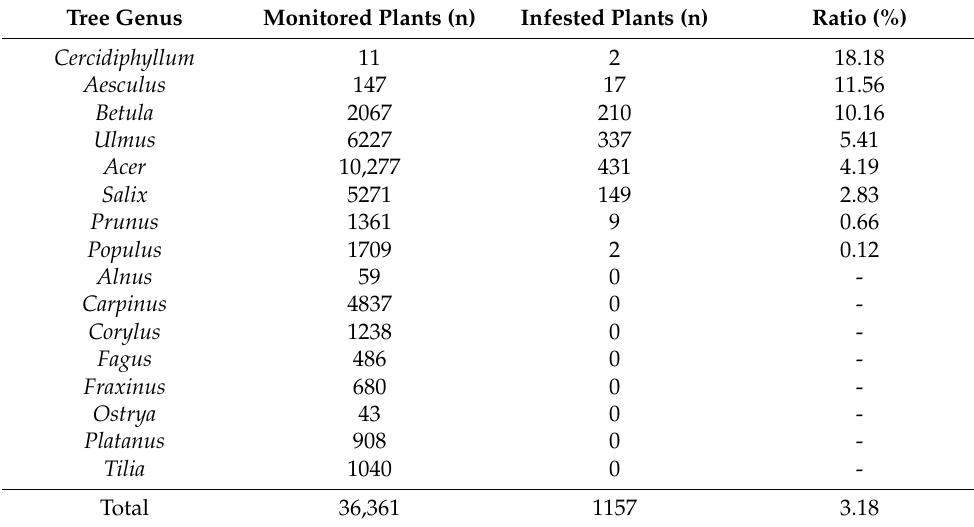
Table 2. Number of monitored and infested trees, with relative percentages of infestation, divided by genera.